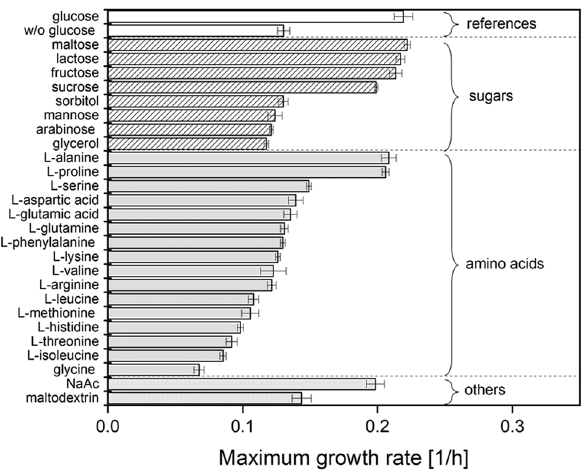
Figure 3. Specific growth rates from microplate cultivation of S. pasteurii with substituted main carbon source. All cultivation experiments were performed in improved chemically defined media with modified carbonsource (Table 1, tripled components marked with asterisk). Culture conditions: 48-well Flower Well Plate, filling volume 800 µ L, shaking frequency 1200 rpm, shaking diameter 3 mm and temperature 30 mean values derived from biological replicates (N = 3, N = 6 for the references with and without glucose) are shown. The error bars depict the standard